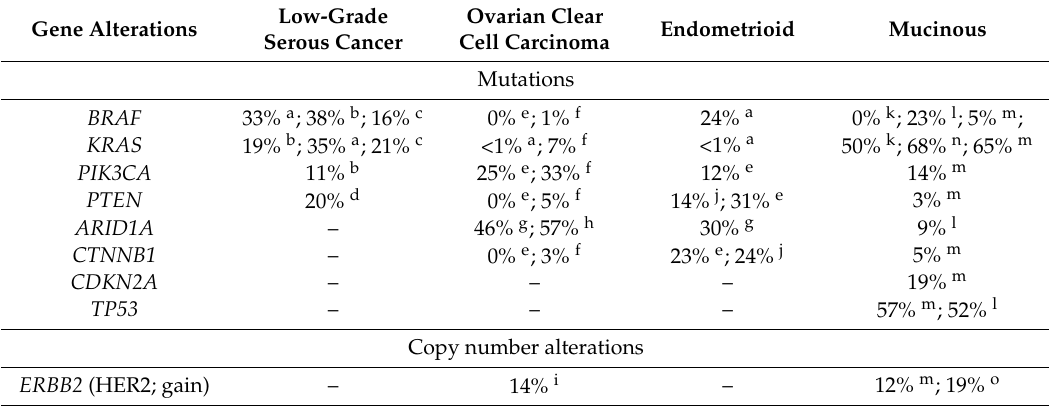
Table 1. Type I ovarian cancers: Frequencies of selected potentially pathogenic genomic